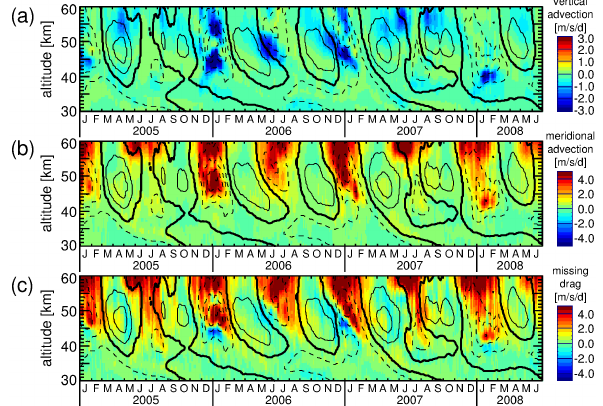
Figure A1. Altitude–time cross sections of the following terms of the ERA-Interim tropical momentum budget in ms − 1 d − 1 : (a) ver- tical advection term, (b) meridional advection term, and (c) missing drag that is attributed to gravity waves (see also Fig. 1d). All val- ues are averages over the latitude band 10 ◦ S–10 ◦ N. Contour lines represent the zonal wind. The bold solid line is the zero wind line. Dashed (solid) lines indicate westward (eastward) wind. Contour interval is 20ms − 1 .